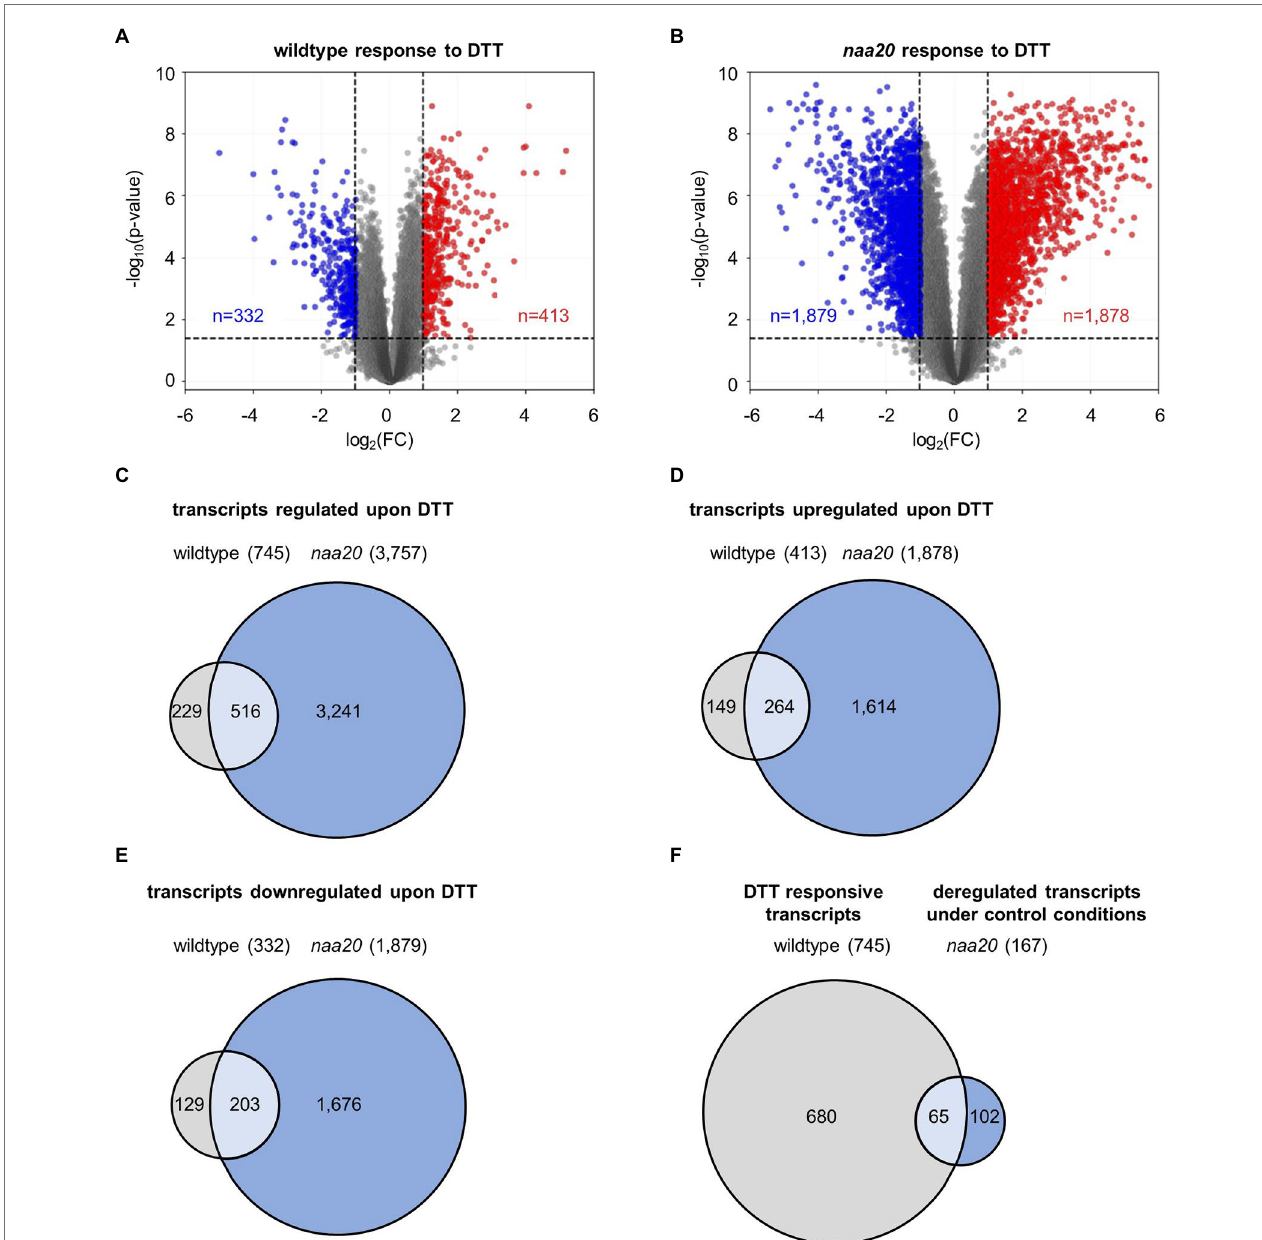
FIGURE 5 | DTT-induced changes in the wildtype and naa20 transcriptome. Total RNA was extracted from 17-day-old naa20 and wildtype seedlings grown on 1 x MS medium with or without 2 mM DTT under short-day conditions ( n = 3). The transcriptome was analyzed with an Affymetrix GeneChip ( n = 27,826). (A,B) Volcano plot analyses of (A) wildtype and (B) naa20 transcriptomes indicate the significantly upregulated (red) or downregulated transcripts (blue) upon DTT treatment (>2- fold; p < 0.05, indicated by dashed lines). (C) Venn diagram displaying the co-regulated transcripts in wildtype and naa20 upon DTT treatment. (D,E) Overlap between co-induced (D) or co-repressed (E) transcripts in wildtype and naa20 . (F) Venn diagram showing overlap of DTT-responsive transcripts in wildtype and constitutively deregulated transcripts in naa20 under control conditions. The reductive stress response is constitutively active in NatB mutants. Of 167 transcripts which are deregulated in naa20 under standard growth conditions, 65 (39%) are responsive to